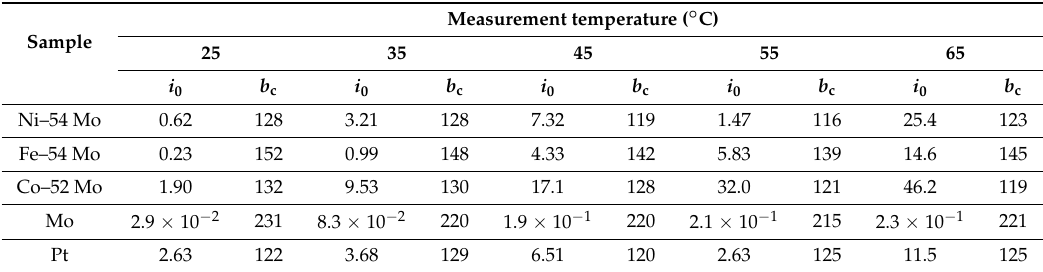
Figure 4. Effect of temperature on cathodic polarization curves at Ni–54 Mo ( a ), Fe–54 Mo ( c ), Co–52 Mo ( e ) electrodeposits in 30 wt.% KOH at different temperatures and plots in semi-logarithmic coordinates for Ni–54 Mo ( b ), Fe–54 Mo ( d ), Co–52 Mo ( f ) electrodes. The scan rate was 2 mV/s (composition is given in at.%). Table 4. Experimental values of the apparent exchange current ( i 0 , in mA/cm 2 ) and Tafel slopes ( b c , in mV/dec) for Ni–54 Mo, Co–52 Mo and Fe–54 Mo alloy electrodes at different temperatures (composition is given in at.%).